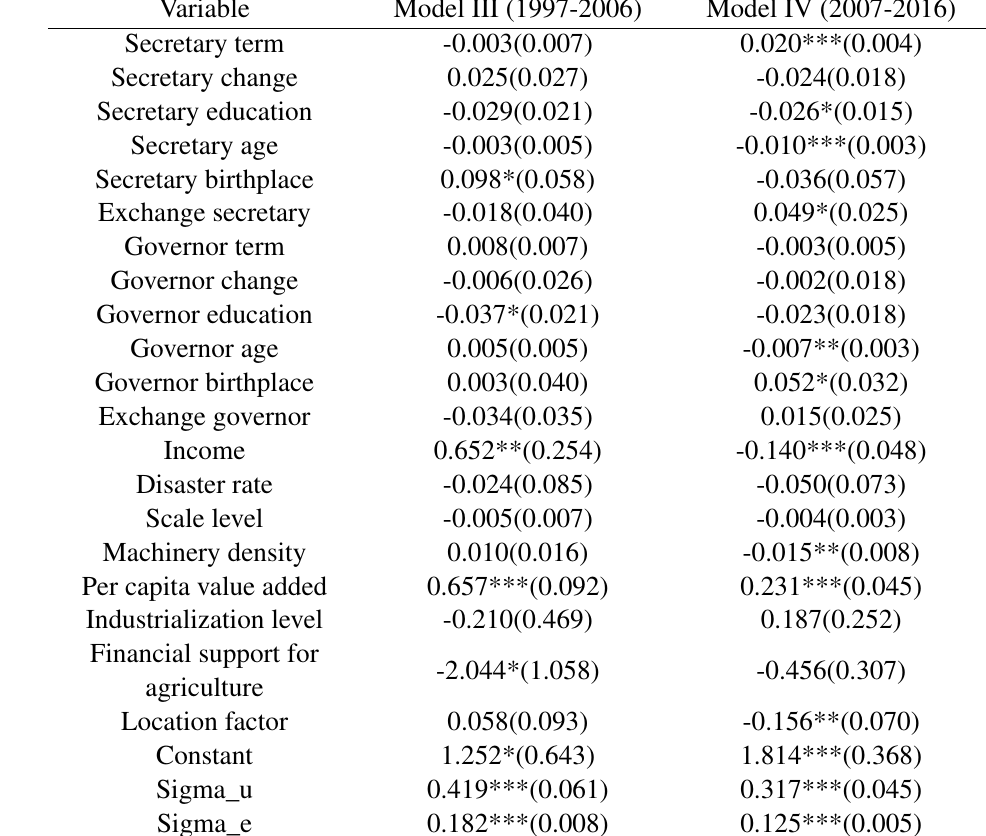
Table 6 Impacts of officials on green agricultural TFP in different